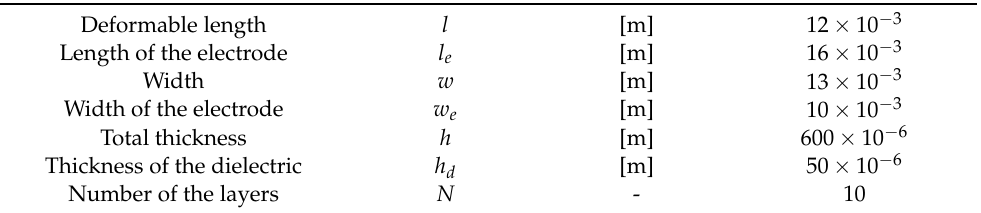
Figure 4. The schematic ( left ) and photo ( right ) of a DEA sample attached to a weighting mass. Table 1. Size of the DEA.